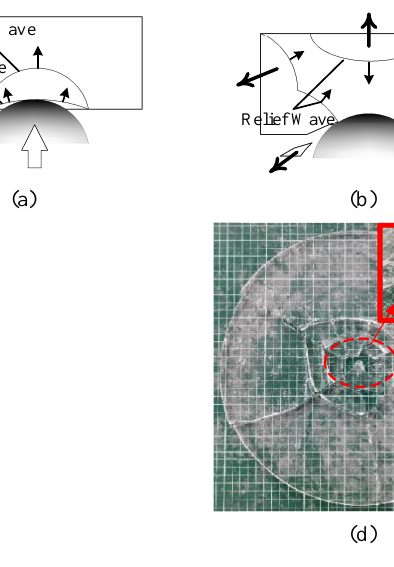
Figure 9. Schematic sequence of events in the impact, adapted from [29]: ( a ) immediately after impact, stress waves are generated; ( b ) relief waves propagate from the upper surface and fine debris splits away off; ( c ) interacting relief waves cause fragmentation and spalling; and ( d ) the broken ice plate is reassembled, and the center of the ice plates forms some sloped fractures due to the impact of the sphere.